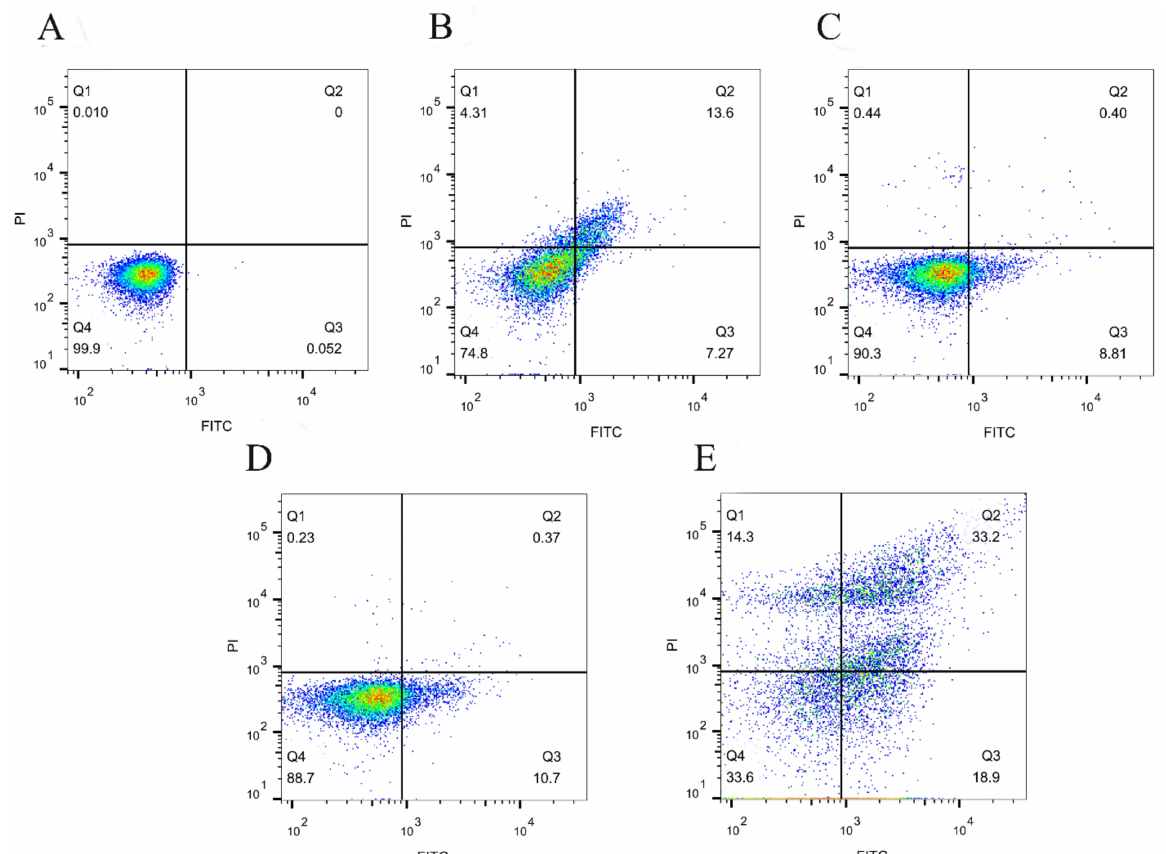
Figure 7. Membrane depolarization of Listeria monocytogenes detected by flow cytometry with An- nexin V-FITC/PI double staining. ( A ) Control group without treatment; ( B ) Curcumin-treated group; ( C ) Light-illuminated group; ( D ) Ultrasound-treated group; ( E ) Curcumin-mediated sono- photodynamic treated group. The two-parameter dot plot divides the cells into four zones: Q1 in- dicating mechanically damaged cells (Annexin V-FITC-/PI+), Q2 indicating dead with membrane depolarization (Annexin V-FITC+/PI+), Q3 indicating bacteria with apoptosis-like event membrane depolarization (Annexin V-FITC+/PI − ), and Q4 indicating live cells (Annexin V-FITC-/PI −